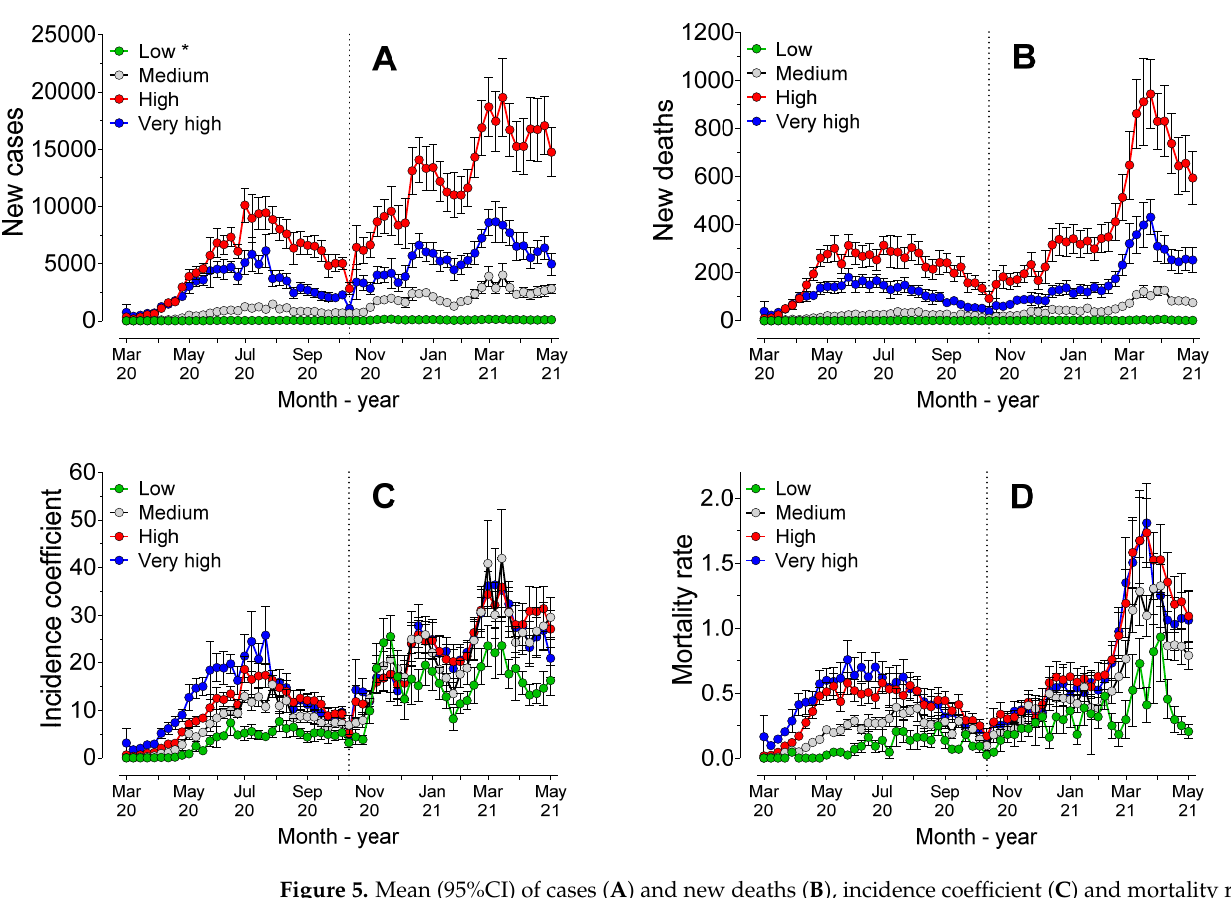
Figure 5. Mean (95%CI) of cases ( A ) and new deaths ( B ), incidence coefficient ( C ) and mortality rate ( D ), over the course of 62 weeks of the pandemic, according to the Municipal Human Development Index (HDI-M) of the cities. * Very low HDI-M (0 to 0.499); low HDI-M (0.500 to 0.599); medium HDI-M (0.600 to 0.699); high HDI-M (0.700 to 0.799); and very high HDI-M (0.800 to 1.0).